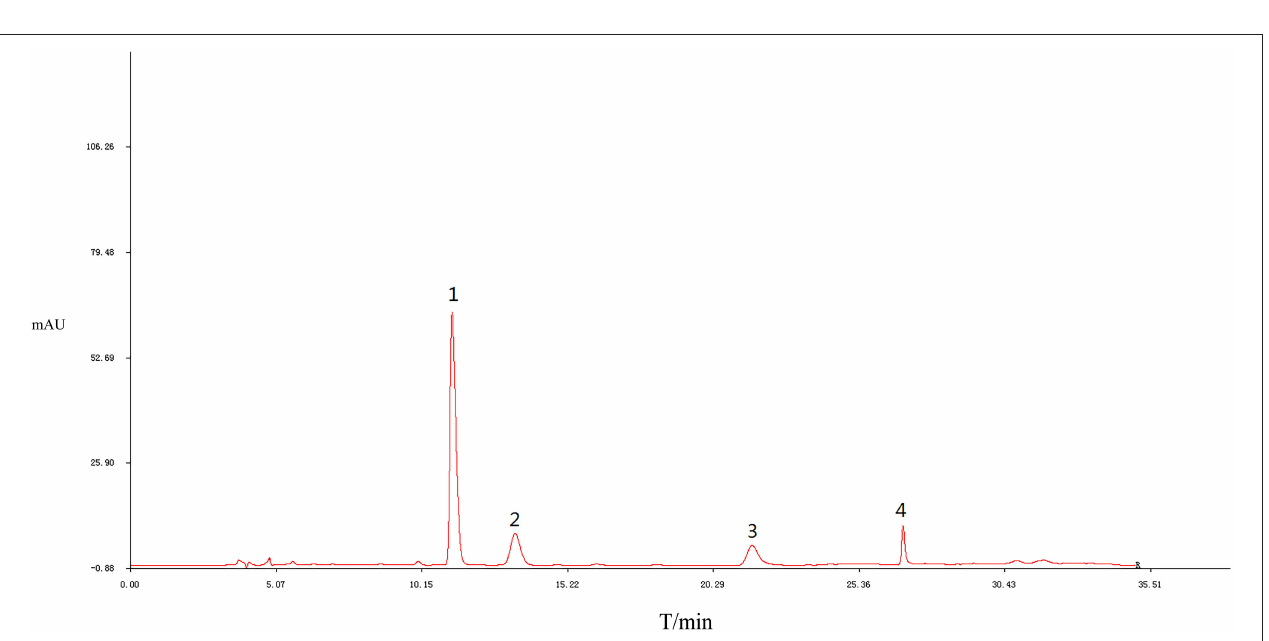
FIGURE 3 | Control characteristics spectrum of MPTA. Peak 1: protopine; Peak 2: allocryptopine; Peak 3: sanguinarine; and Peak 4: chelerythrine.